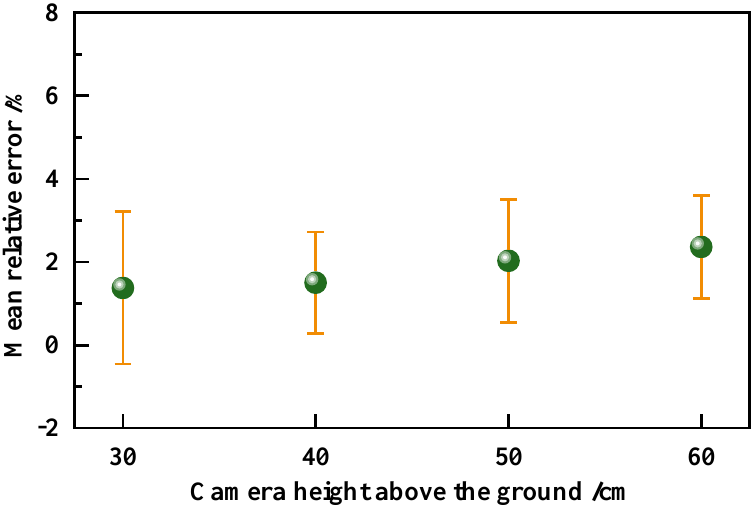
Figure 9. Relative error analysis of prediction at different altitudes.